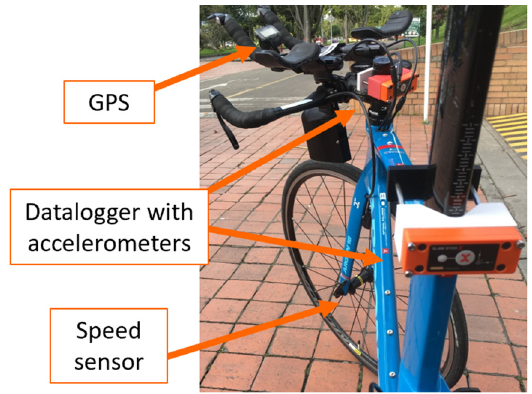
Figure 5. Setup for the characterization of vibrations transmission.